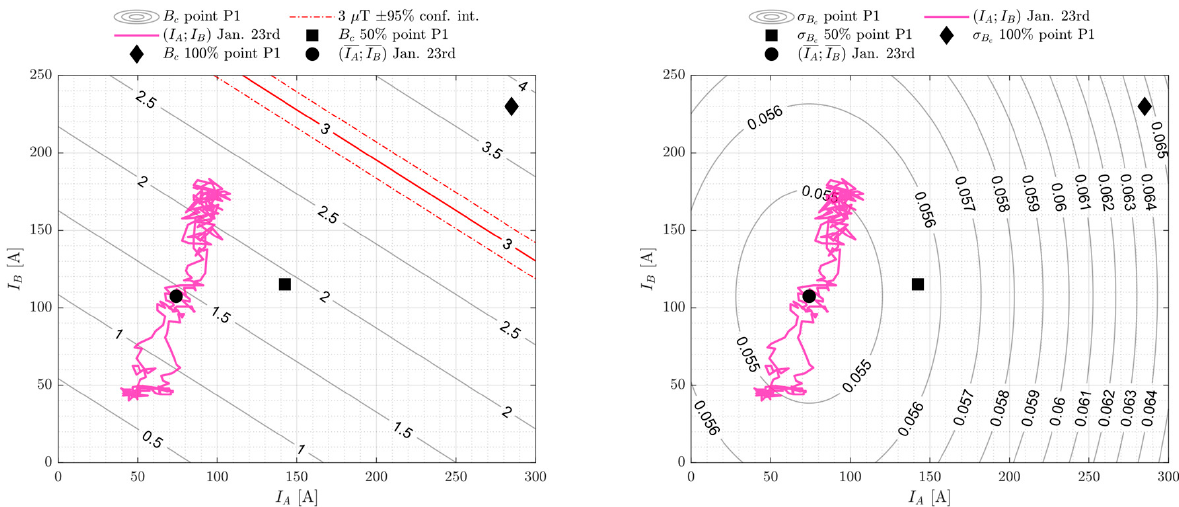
Figure 11. Positions P1 field ( left ) and its standard deviation ( right ) evolution (pink trace) over the 24 h as a function of the currents in circuits A and B (i.e., I A and I B ). Current barycenter, and field evaluated at 50% and 100% of the line capacity are reported in all the frames.